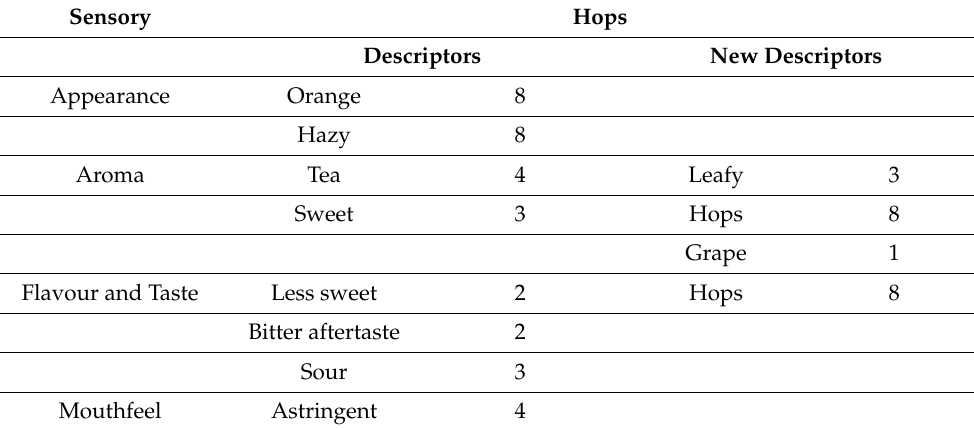
Table 5. The results from the sensory focus group of eight panellists. The descriptors were based on the commercial Kombucha beverages, and the new descriptors were from the hops Kombucha